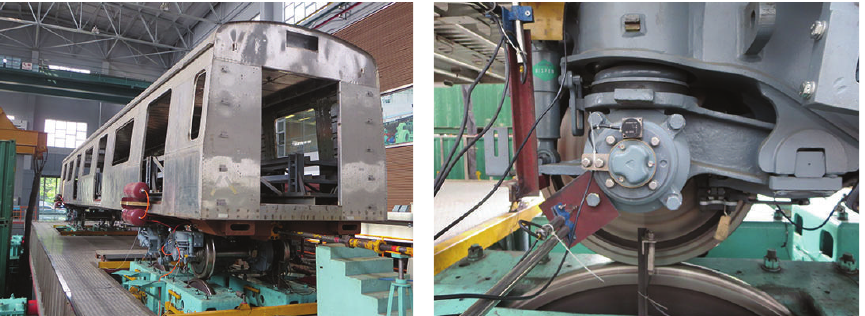
Figure 19: Experimental setup.